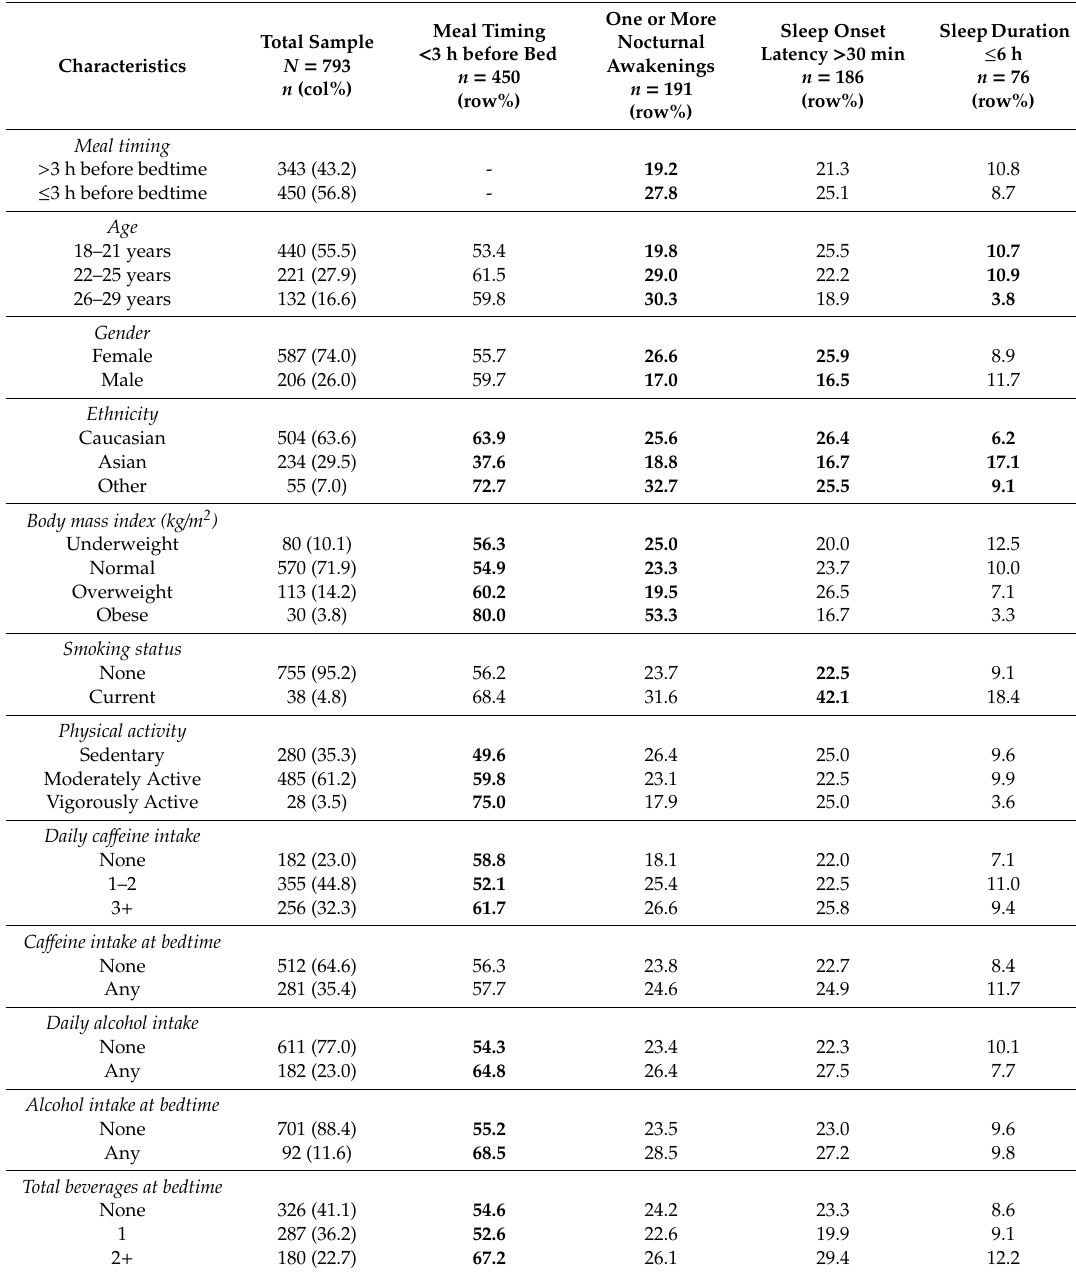
Table 1. Meal timing and sleep by sociodemographic and behavioural risk factors in students aged 18–29 years ( N =